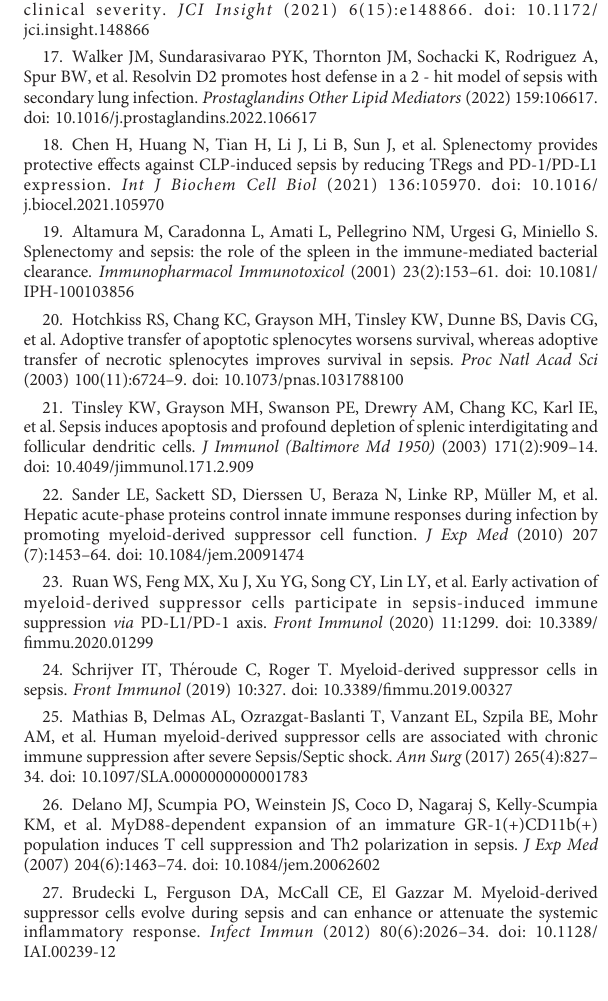
SUPPLEMENTARY FIGURE 1 Gating Strategy: Myeloid-derived suppressor cells were gated based on size (FSC) and granularity (SSC), singlets, live cells, expression of CD11b, Ly6G, and Ly6C in a quadrant gate. Similarly alveolar macrophages were gated based on size (FSC) and granularity (SSC), singlets, live cells, expression of SiglecF and non-expression of CD11b in a quadrant gate.